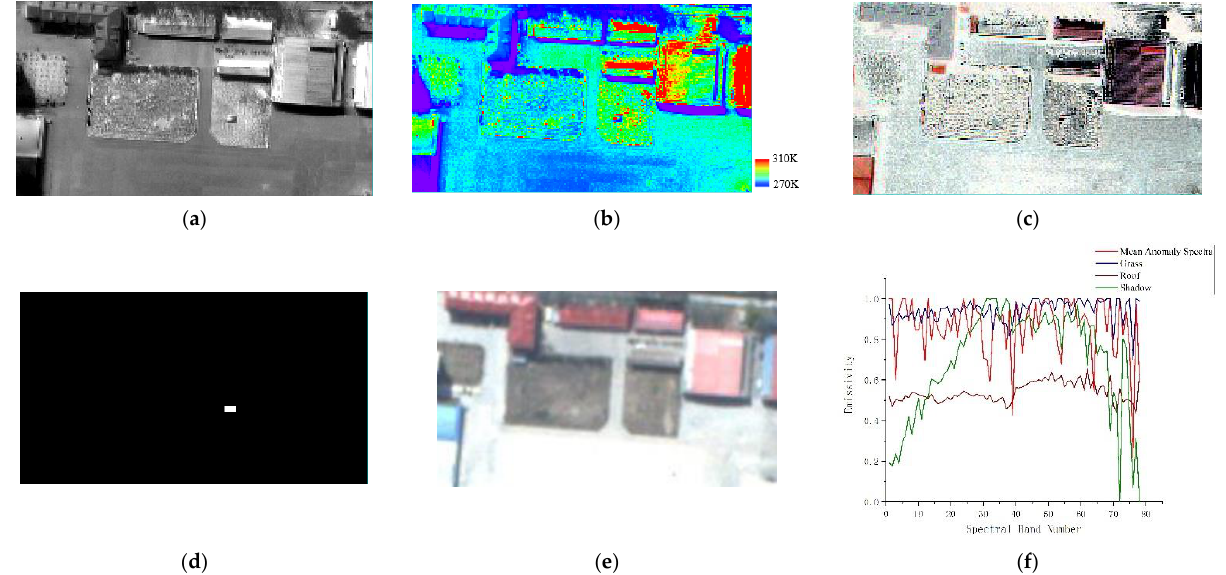
Figure 12. Car data set. ( a ) Radiance domain; ( b ) temperature image; ( c ) emissivity RGB pseudo-color image synthesized by band 8, 11, 25; ( d ) ground-truth map; ( e ) RGB image; and ( f ) emissivity spectral signatures of anomalies and background.